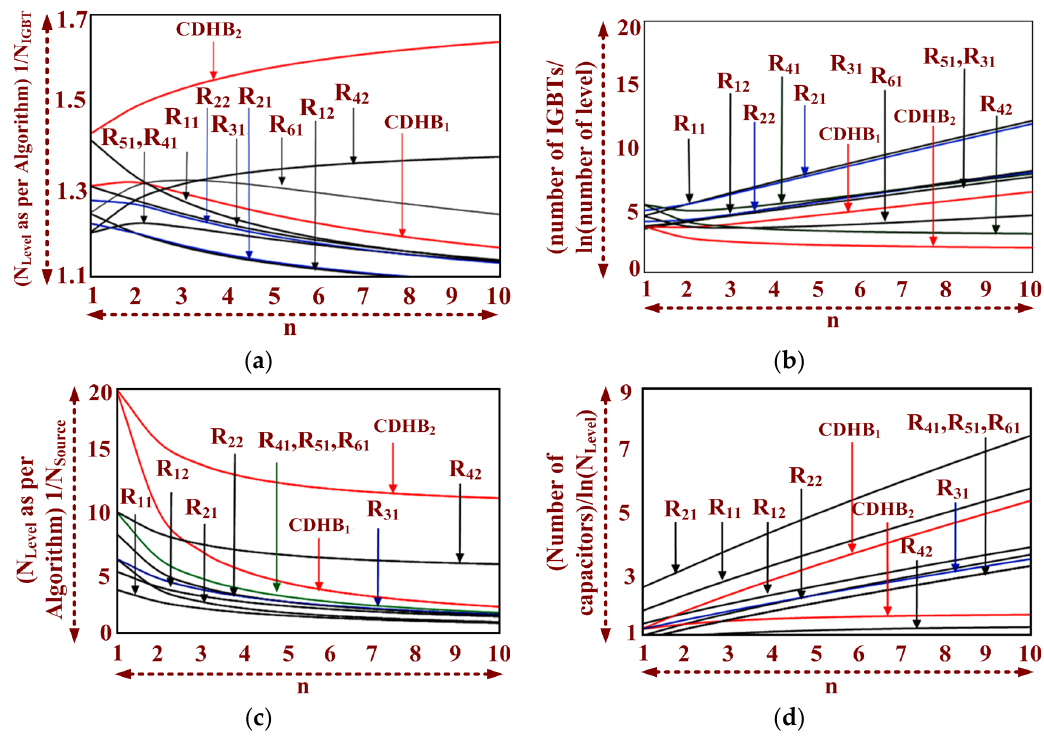
Figure 6. Comparison of proposed topology with various topologies algorithms for ( a ) N Level with constant N IGBTs , ( b ) N IGBTs with constant N Level , ( c ) N Level with constant N source , ( d ) N capacitor with constant N Level .